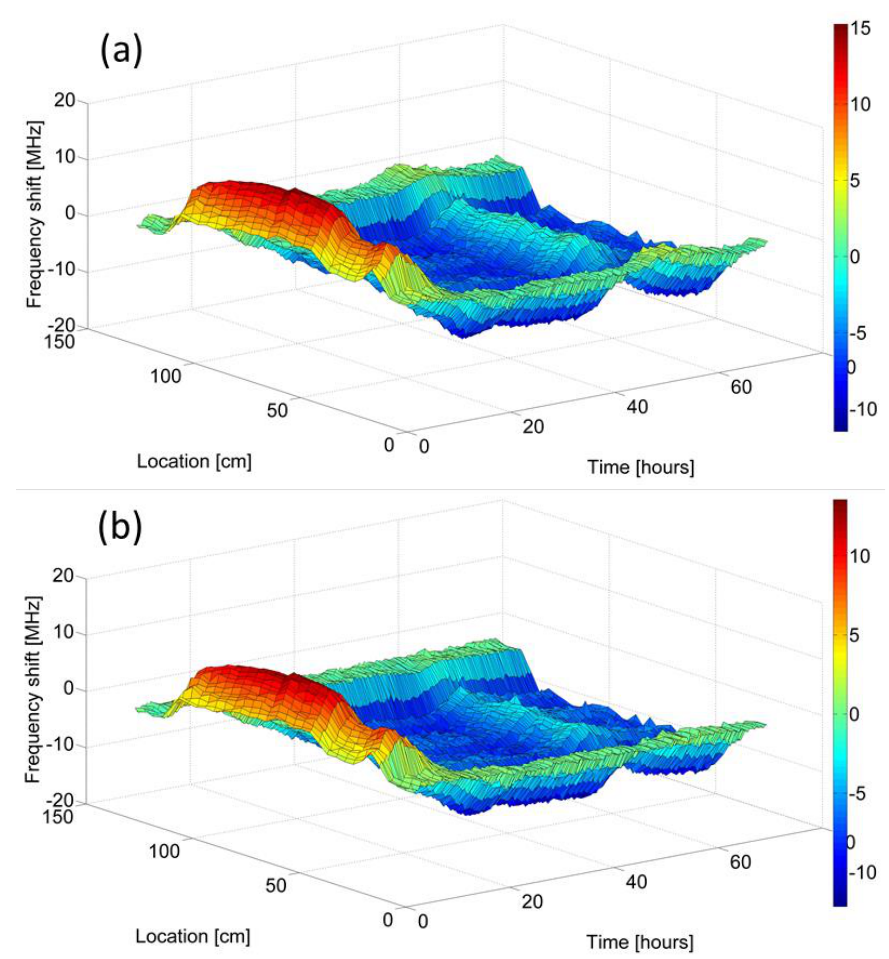
Figure 2. Measured Brillouin frequency shift as a function of position 𝑧 along a fiber under test, and time elapsed since the installation of the fiber underneath the upper structural layer of a composite beam [41,42]. Phase-coded Brillouin optical correlation domain analysis was carried out at 20 min intervals for 60 h, during and following the production of the beam, with 4 cm resolution. ( a ): Offset of the Brillouin frequency shift from a nominal value of 10.85 GHz. ( b ): same as panel (a), following the subtraction of reference readings that were taken over the lead-in fibers outside the beam. The reference readings were updated once every 20 min. Variations in the laboratory temperature over the 60 h of measurements are therefore eliminated.